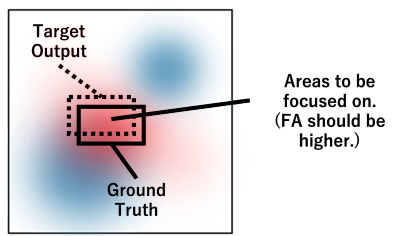
Figure 2. Conceptual diagram of the method for the evaluation of learning. The background image illustrates the saliency map of